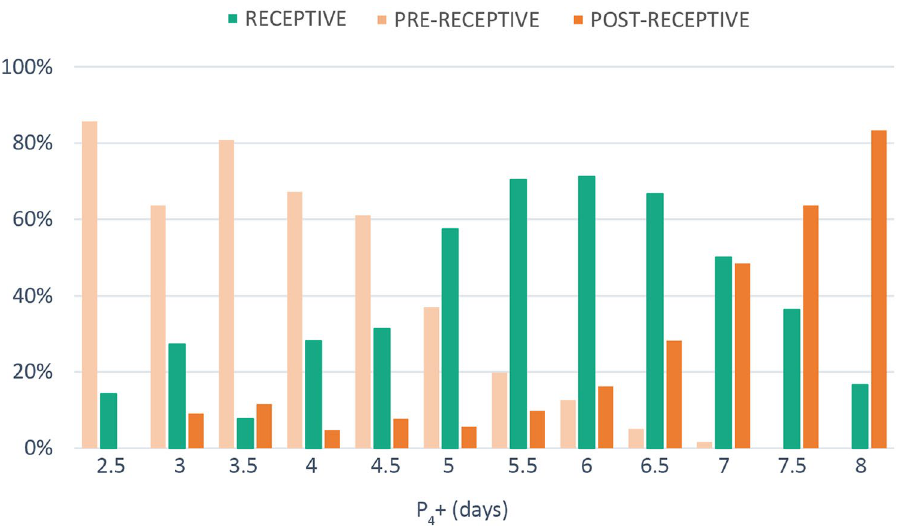
Figure 1. Endometrial receptivity status frequencies along different days of progesterone administration as assessed by ER Map. Frequencies of receptive, pre-receptive and post-receptive samples after a variable number of days of progesterone administration. N = 2828